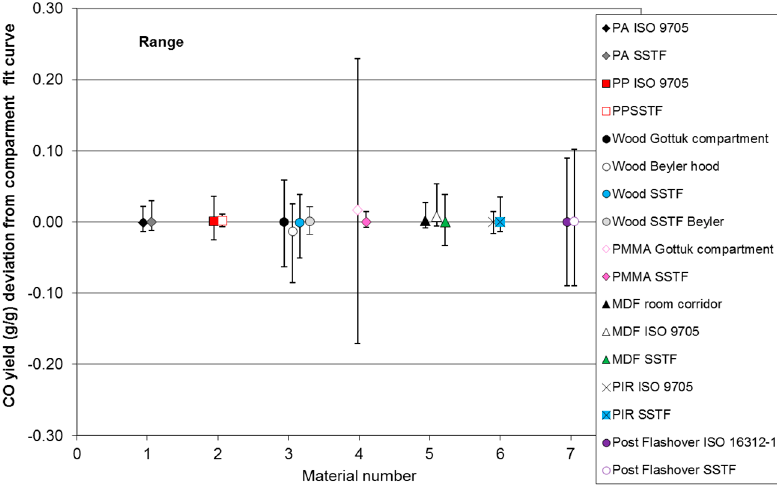
Figure 4. Means and ranges of deviations from the trend lines for compartment fire CO yields and from compartment fire trend lines for SSTF CO yields.